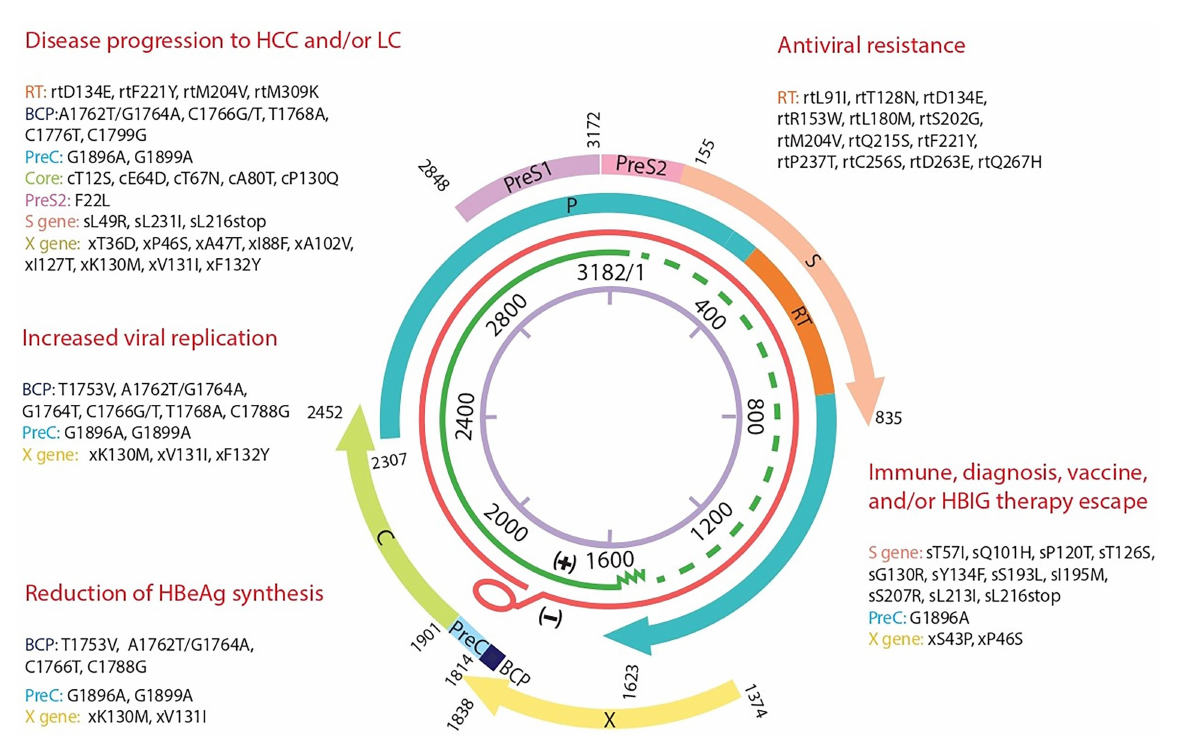
FIGURE 3 Hepatitis B genome map with summary of the most significant mutations and their clinical impact detected in 5 Tunisian HBV patients. A representation of the four overlapping genes encoding the polymerase P, the surface gene S, the capsid gene C, and X gene. The detected significant mutations are grouped depending on their clinical impact based on the literature. BCP, Basal core Promotor; C, core; PreC, precore; S, surface; RT, reverse transcriptase; HBIG,